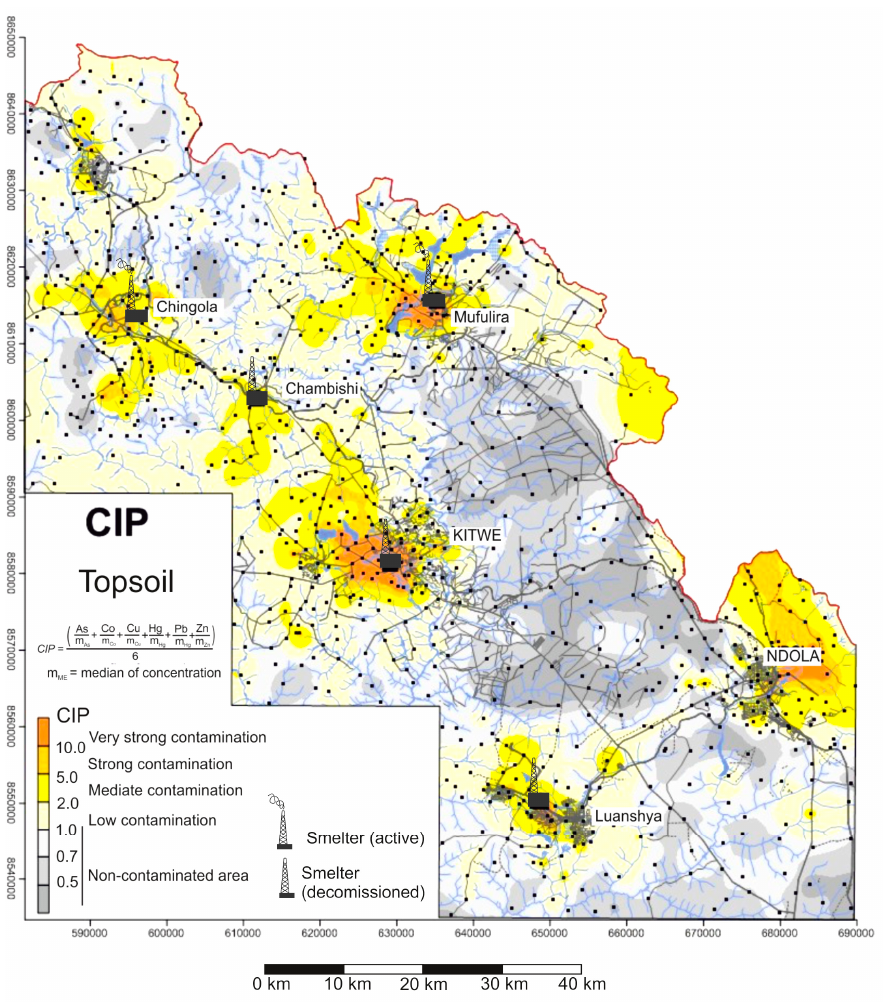
Figure 9. Contour map of the Coeficient of the Industrial Contamination (CIP) in topsoil in the surveyed area of the Zambian Copperbelt. Sampling points are shown as black dots. Modified after K ř íbek and Nyambe [74].